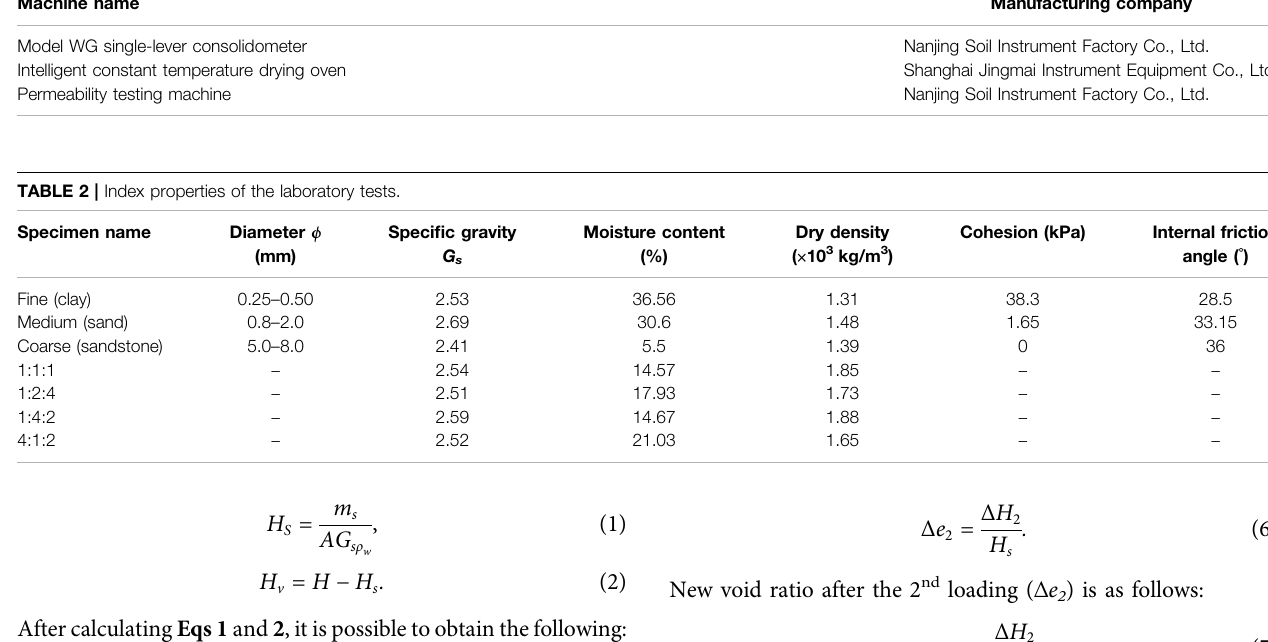
TABLE 1 | Machine description.